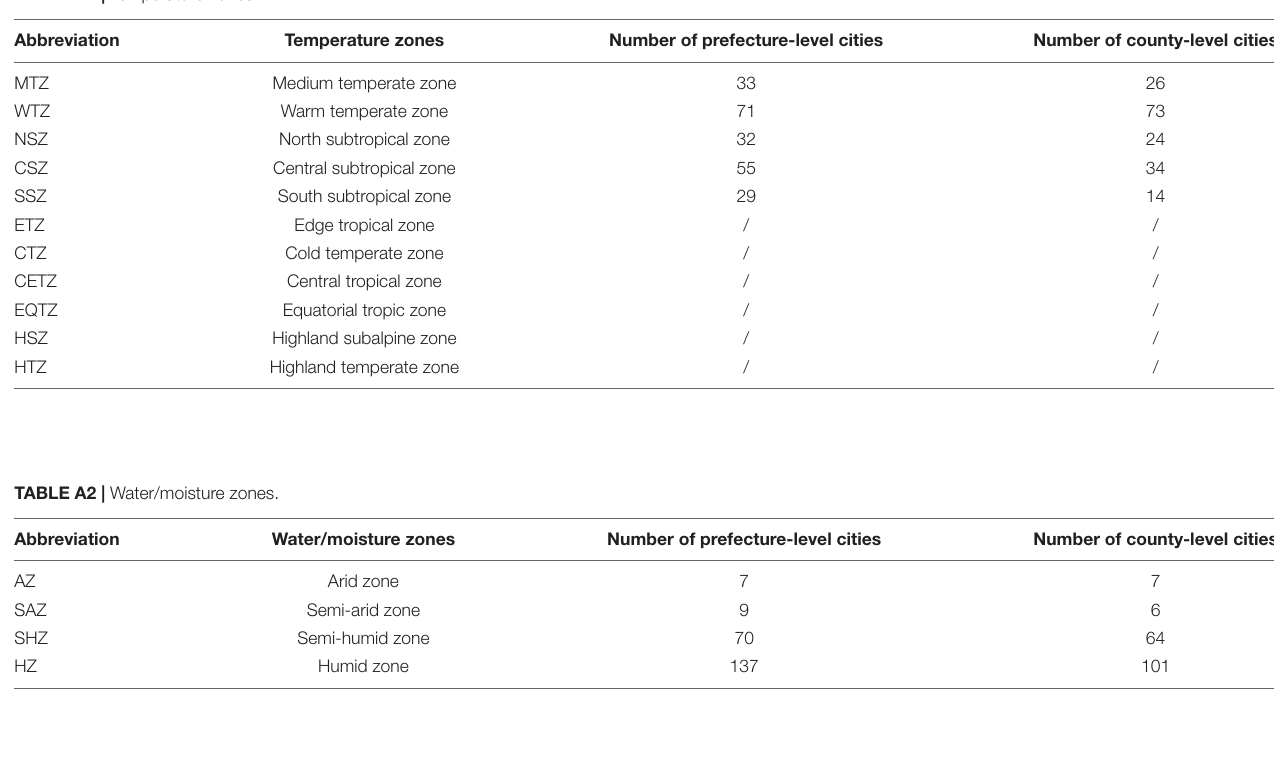
TABLE A1 | Temperature zones.